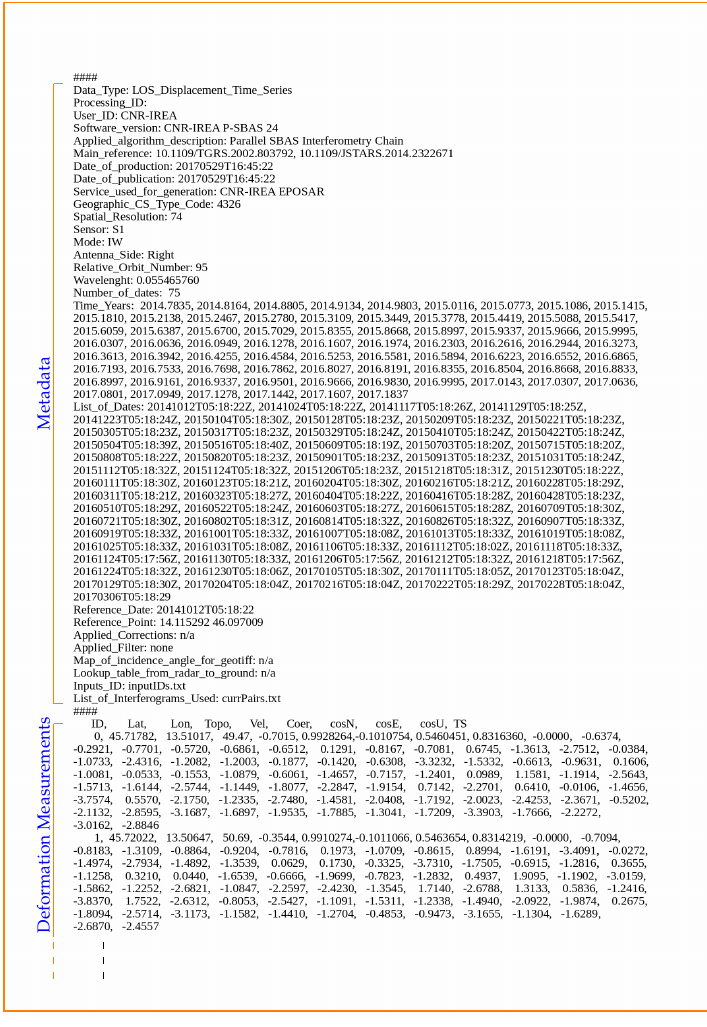
Figure 5. Sample text file showing the exploited DInSAR results data format; note that the metadata and deformation measurements are